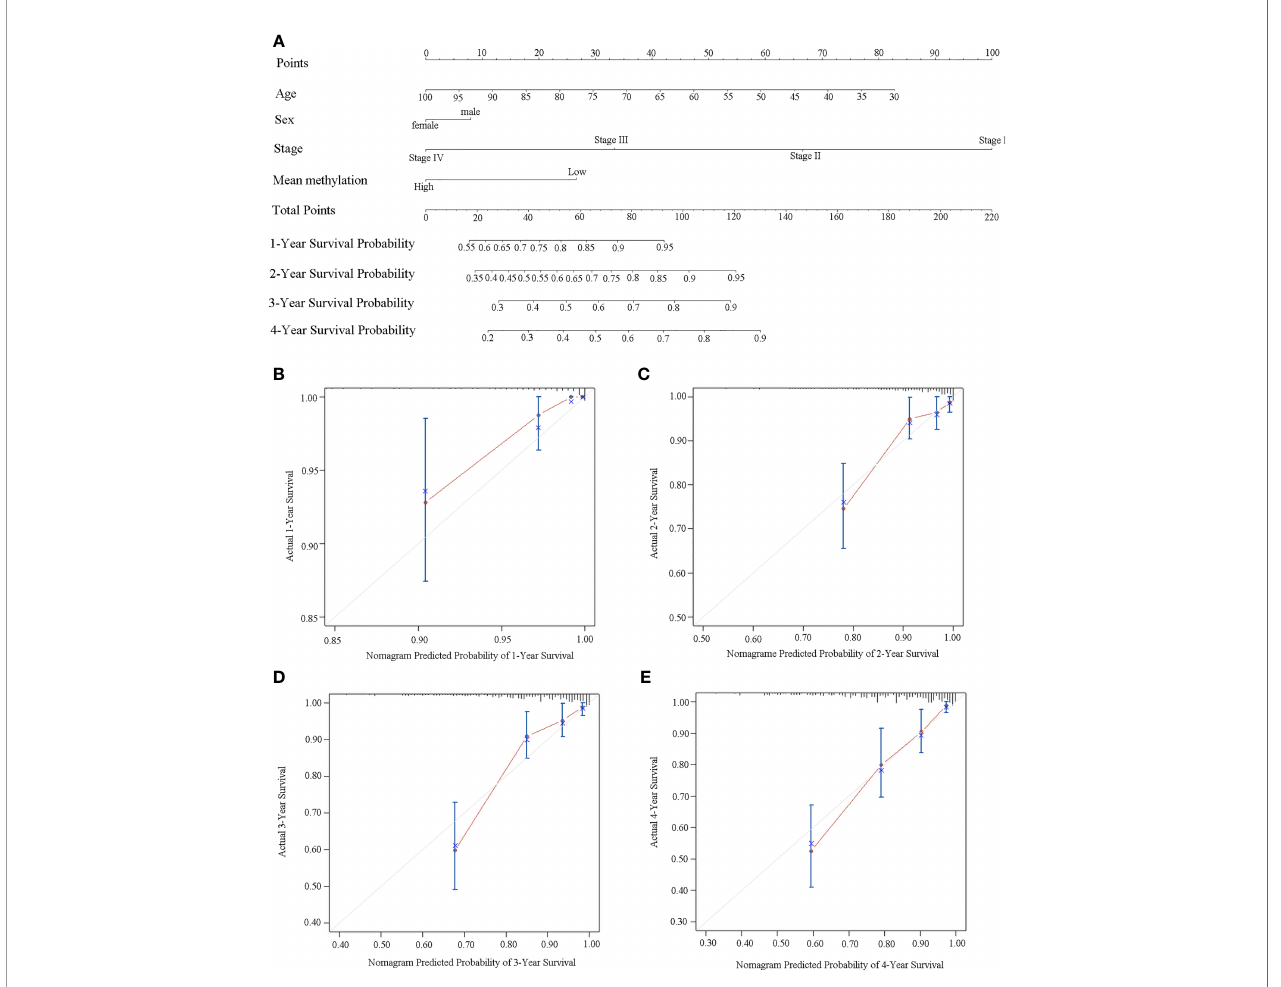
FIGURE 7 | Establishment of a nomogram for survival prediction in our dataset. (A) Nomogram to predict the 1-, 2-, 3-, and 4-year survival of CRC patients. Calibration curves of (B) 1-year, (C) 2-year, (D) 3-year, and (E) 4-year survival nomogram model. The gray line represents the ideal predictive model, and the red line represents the observed